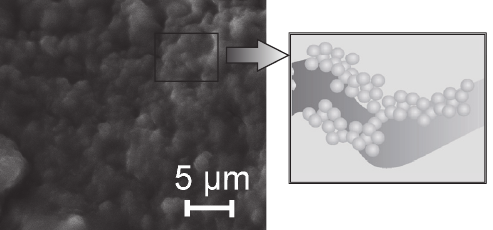
Figure 4: SEM image of the solid phase of the organic-inorganic xerogel prepared from the corresponding hydrogel based on CS-GA and Si(OGly) 4 ⋅ 2Gly \X . A schematic image of the distribution of globular particles of the branched 3D network of ≡ Si–O–Si ≡ bonds on the CS